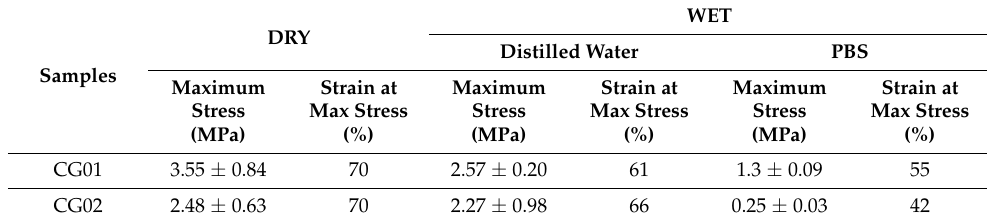
Table 3. The mechanical properties of hydrogels at room